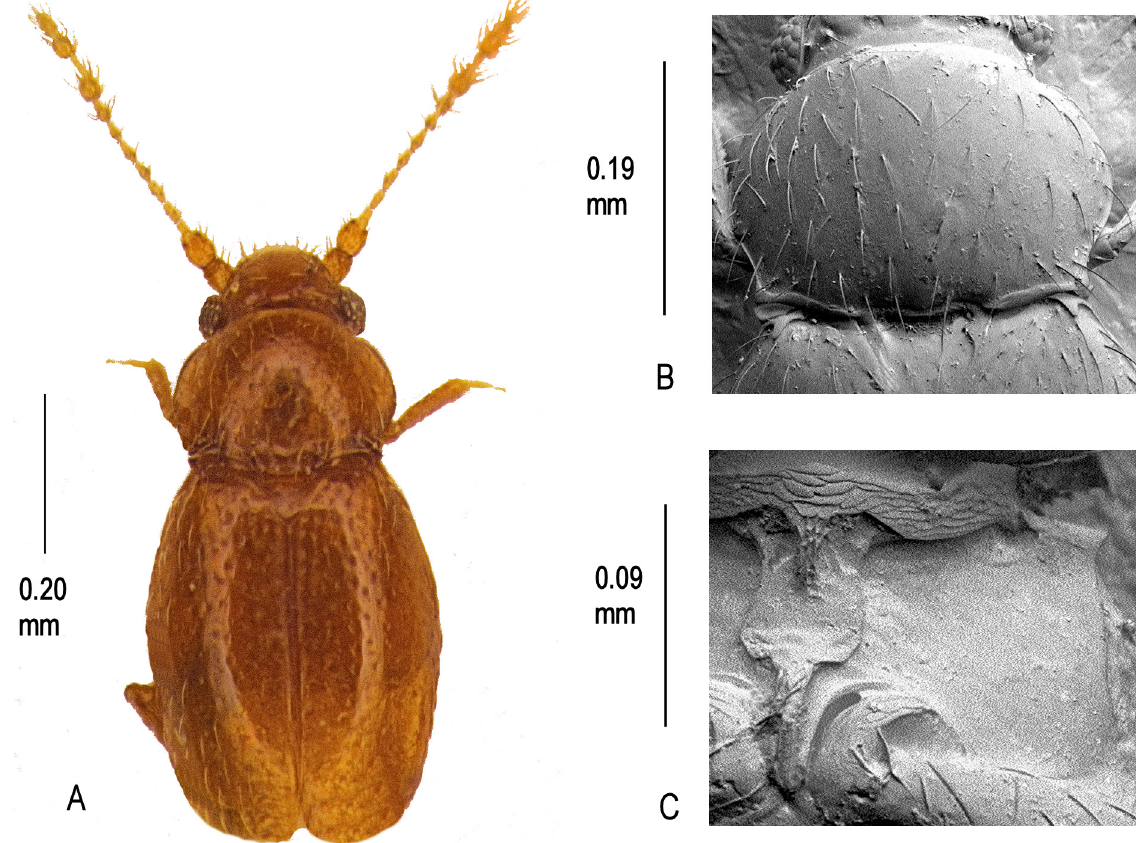
Fig. 80 . Cissidium steeli sp. nov. A . Habitus. B . Pronotum, × 680. C . Mesoventrite showing median process of collar, mid-keel and keel,